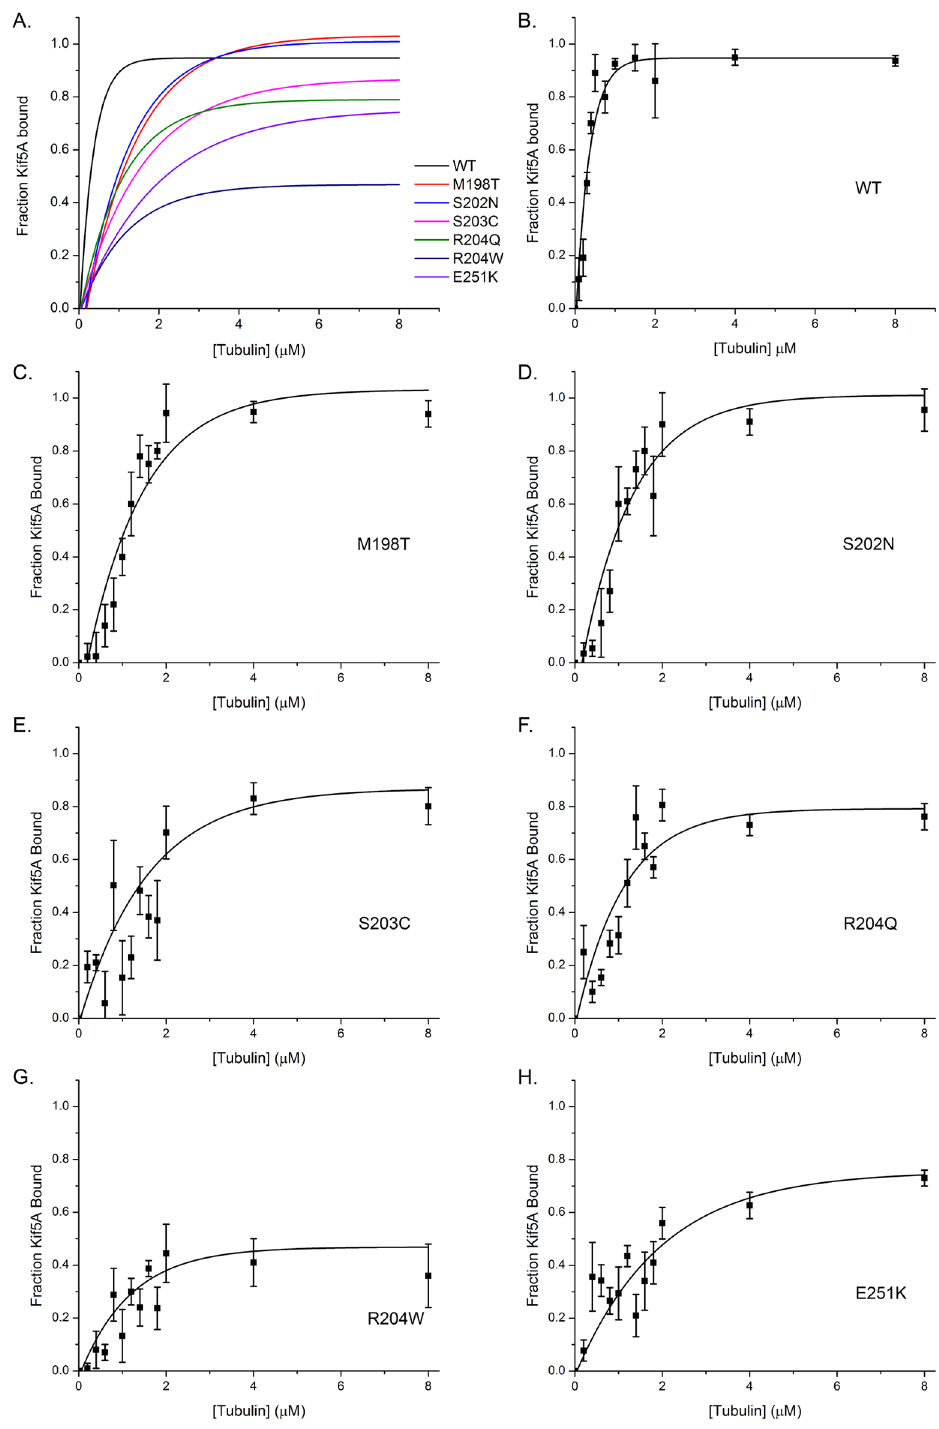
Fig 2. MT affinity in the presenceof AMPPNP. MT pelletingassays were performed as describedfor Fig 1, except 5 mM AMPPNP was substituted in the reactionbuffer. Experiments were repeatedin a range of tubulin concentrations from 0 to 20 μ M and the results of the densitometry analysisof the western blots producedare plotted for each Kif5A mutant. The curves shown are the best fit to the data using the exponential decay function in Origin 8 in a user free computational method. A) Curves of fraction Kif5A boundas a function of tubulin concentration for the wild type and mutant proteins. B-H) Individual Kif5A curves (WT or mutant as indicated) with mean +/- SD for each concentration of tubulin